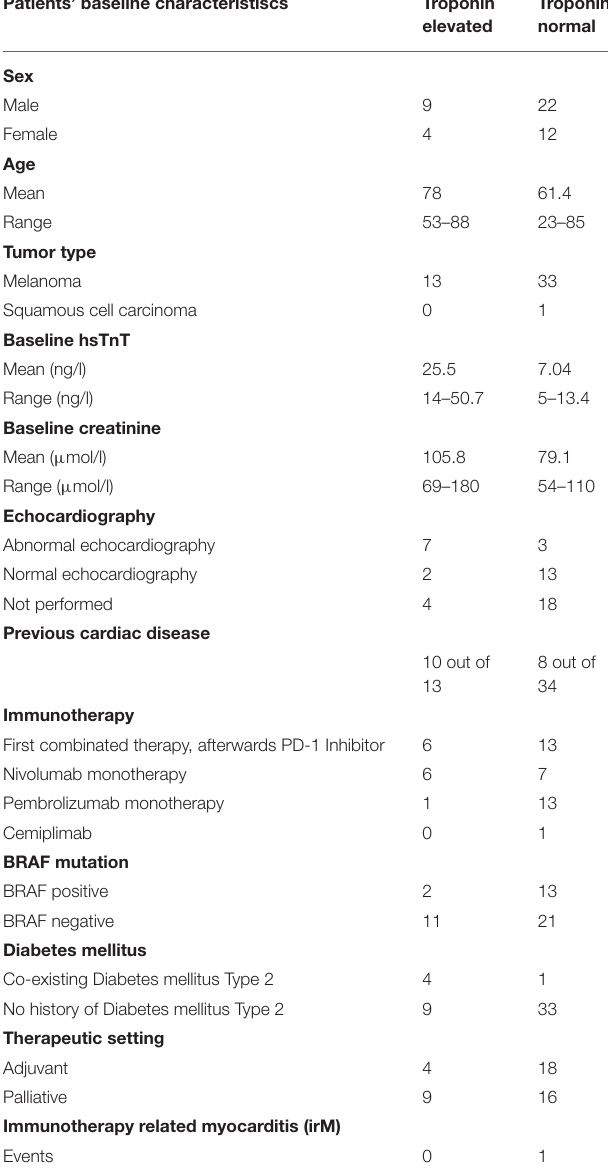
TABLE 2 | Demographics and factors associated with normal and elevated baseline hsTnT concentrations. Patients’ baseline characteristiscs Troponin